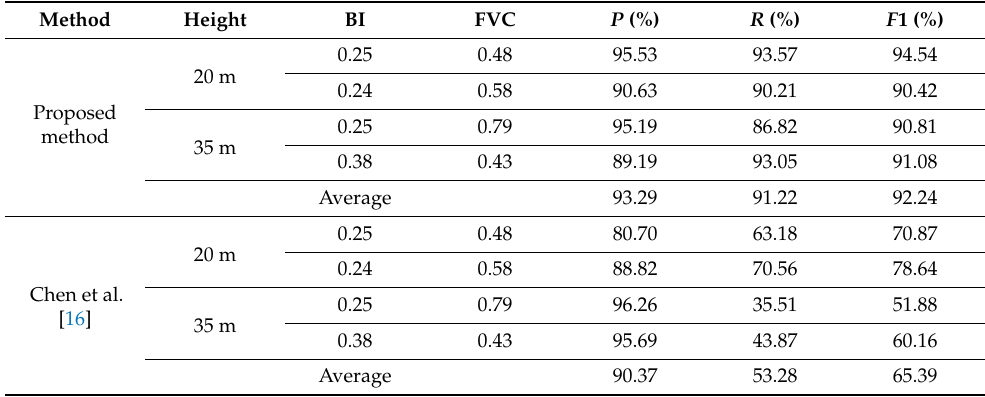
Table 8. Performance comparison of tree counting methods published in the